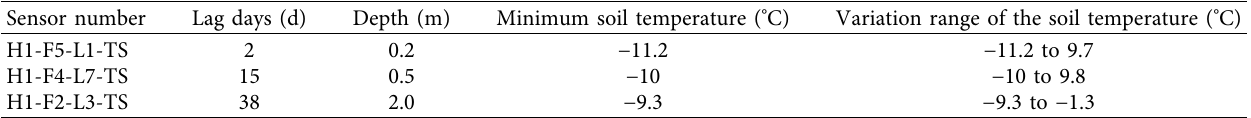
Figure 9: Relationship between the lag days of the minimum soil temperature relative to the minimum air temperature and the embedded depth of the monitoring Table 1: Lag days of the minimum soil temperature relative to the minimum air temperature, the embedded depth of the monitoring sensor, and the variation range of the soil temperature.